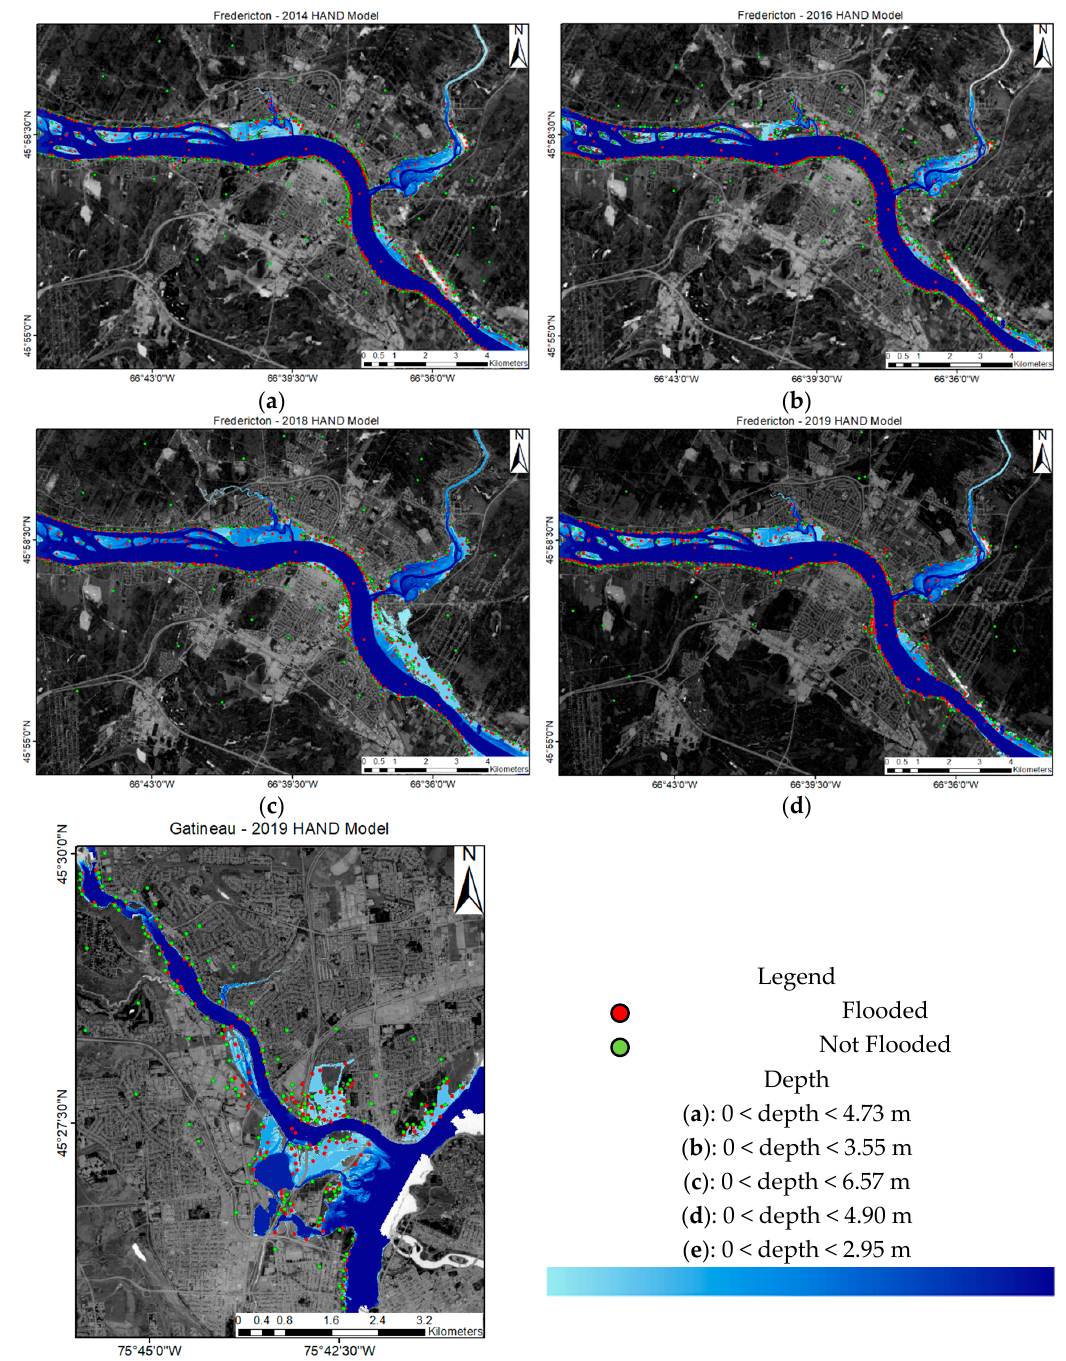
Figure 6. Flood extent for five flood events including Fredericton in 2014 ( a ), Fredericton in 2016 ( b ), Fredericton in 2018 ( c ), Fredericton in 2019 ( d ) and Gatineau in 2019 ( e ) all generated from the HAND model corresponding to the dates of the satellite imagery.